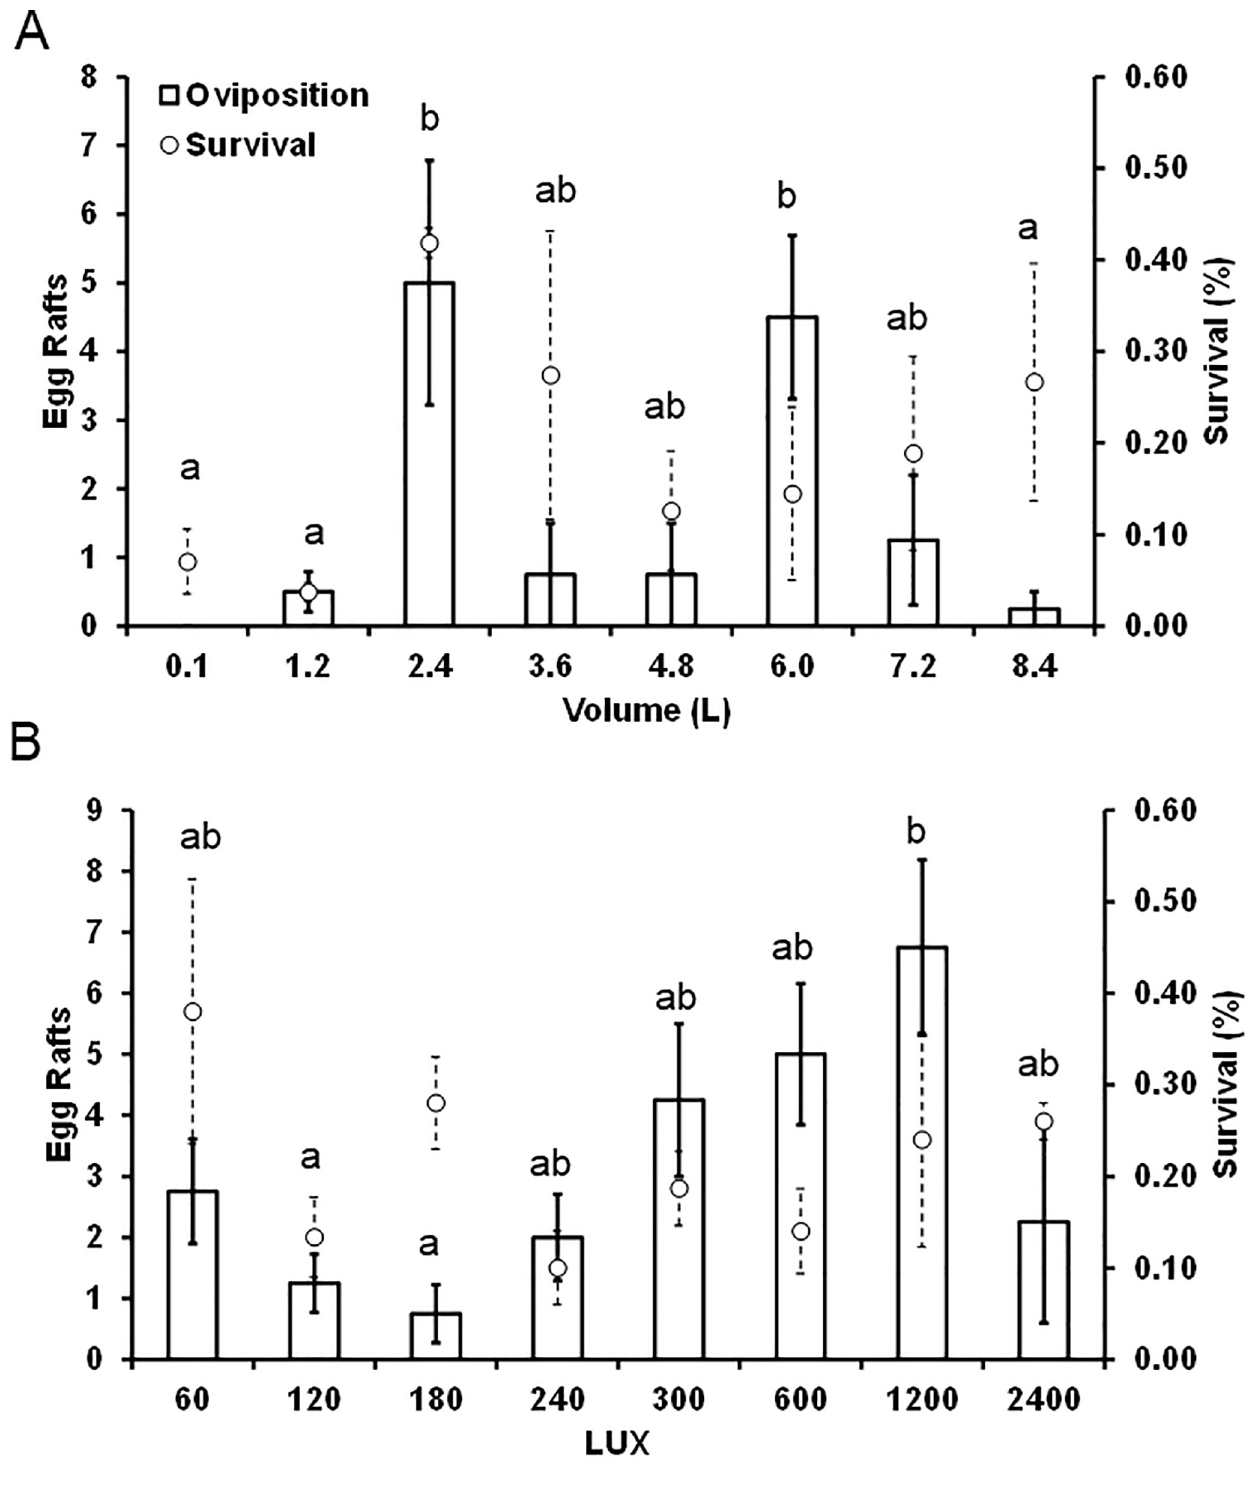
Fig 2. Results (raw means ± SE, dashed for survival, solid for oviposition) from separate experiments examining how environmental factors affect oviposition responses (n = 4 replicates) and larval survival (n = 3 replicates) of Culex quinquefasciatus . A. Response to different water volumes in tires, and B. response to different light levels (higher values of LUX are brighter). Means that share a letter are not significantly different at P = 0.05.